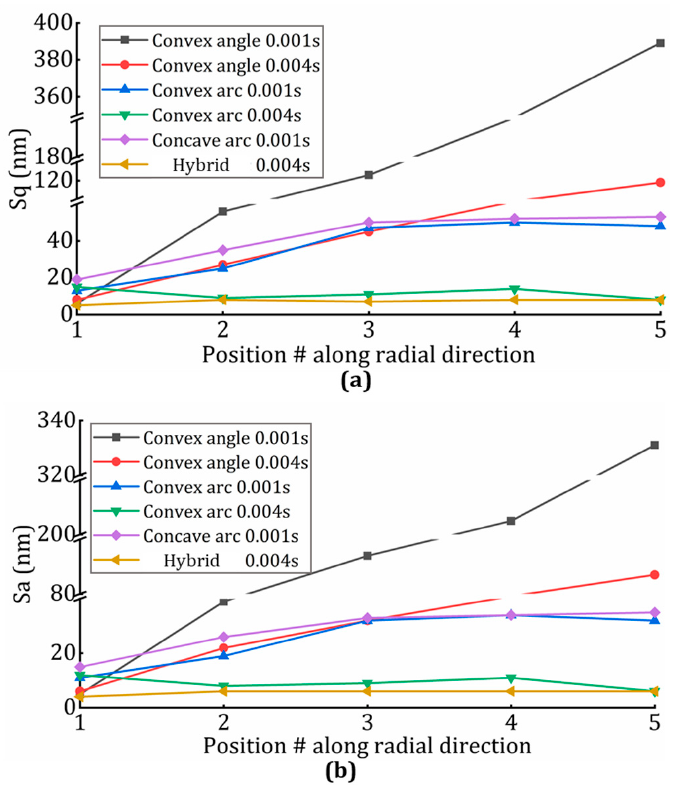
Figure 11. Sq and Sa of lenslets at different positions indicated in Figure 2 for different cutting parameters. Sq and Sa are shown in ( a , b ) after removing the designed spherical surface.